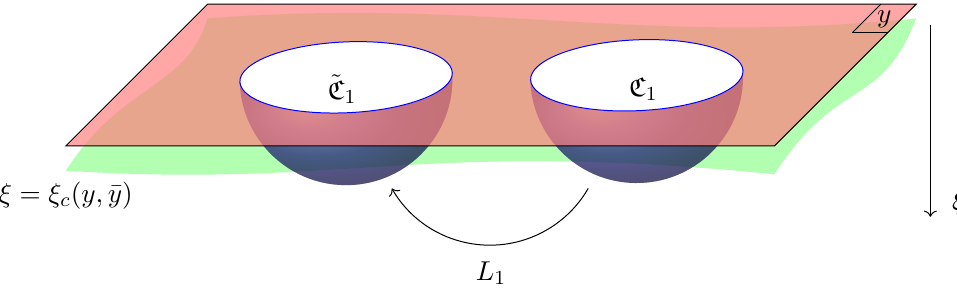
Figure 11 . The bulk fundamental domain of the Schottky construction consisting of two hemi- spheres excised from AdS with their boundaries identified by the action of the Schottky group. 3 The bulk coordinate ξ is cut off by the surface ξ = ξ ( y, ¯ y ) c